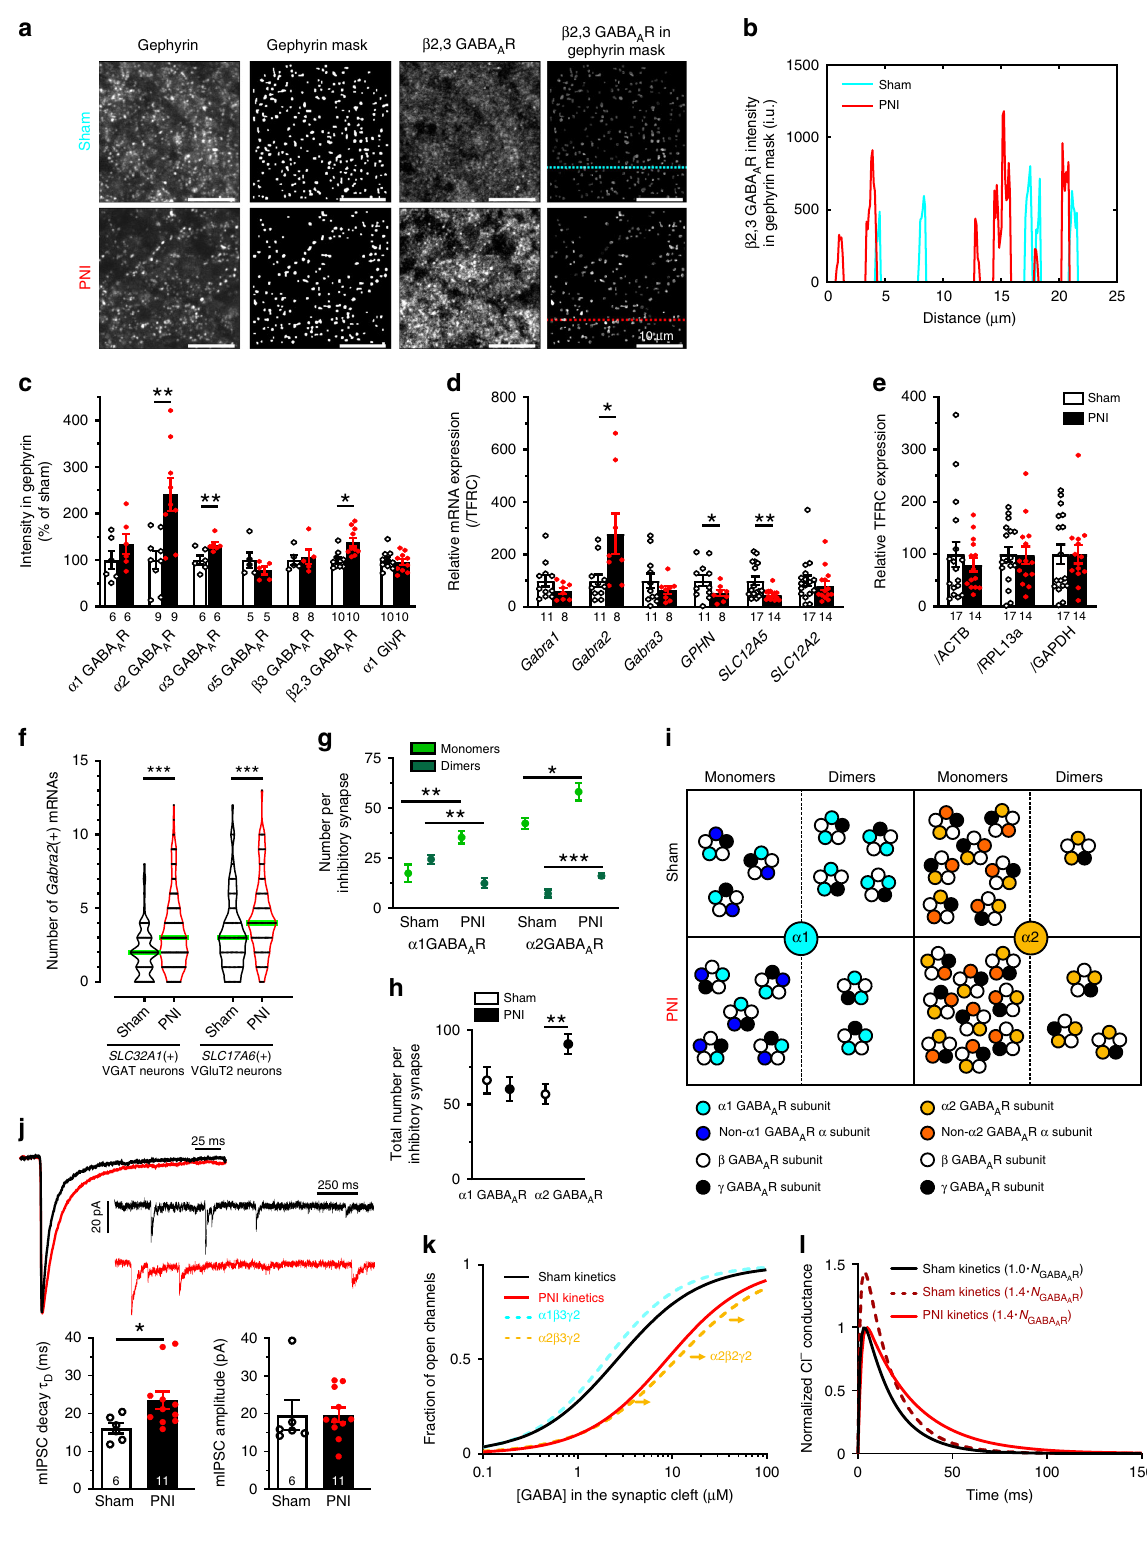
Fig. 2c). The same observations were made with other anti- GABA A R antibodies raised in guinea pig 32 (Supplementary Fig. 1). The increase in β 2 subunits in inhibitory postsynaptic sites suggests a synaptic scaling 33,34 , whereby the number of receptors per synapse was increased. The increase in α 2 and α 3 subunit staining, together with no change in α 1, points to a switch in GABA A R composition at inhibitory postsynaptic sites.